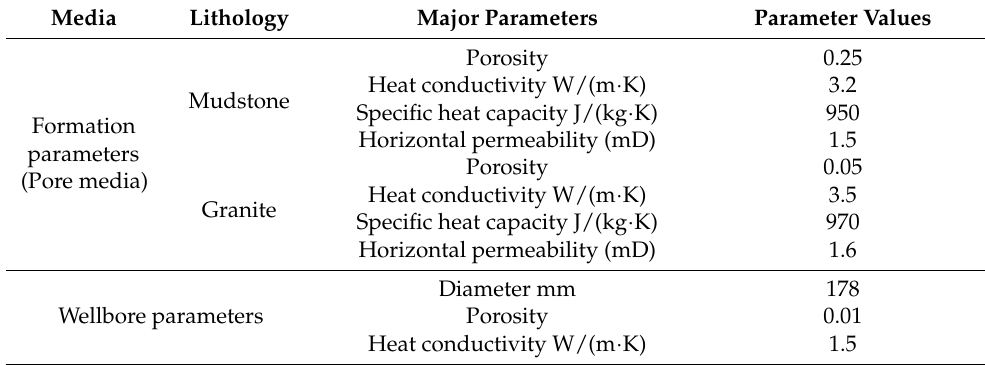
Table 1. Model numerical simulation parameters.